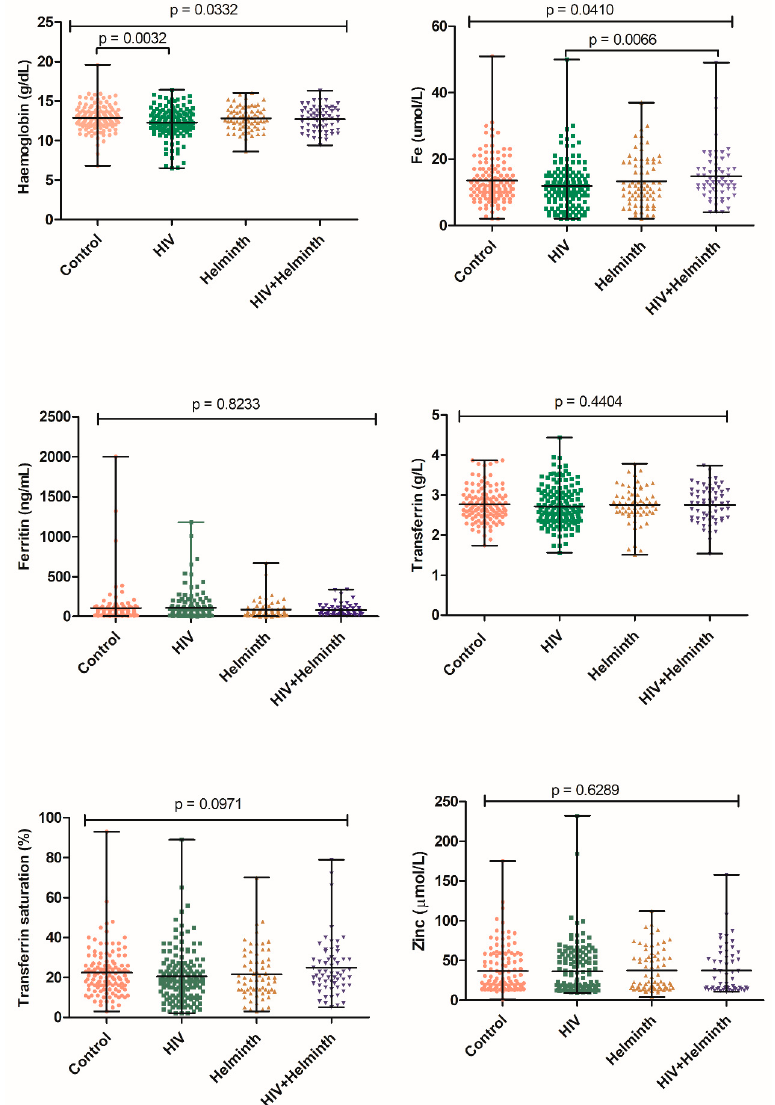
Figure 2. Univariate association of haemoglobin, serum iron, ferritin, transferrin, transferrin satura- tion, and zinc levels in HIV and helminth-infected and uninfected control groups. “Control” refers to the HIV and helminth uninfected